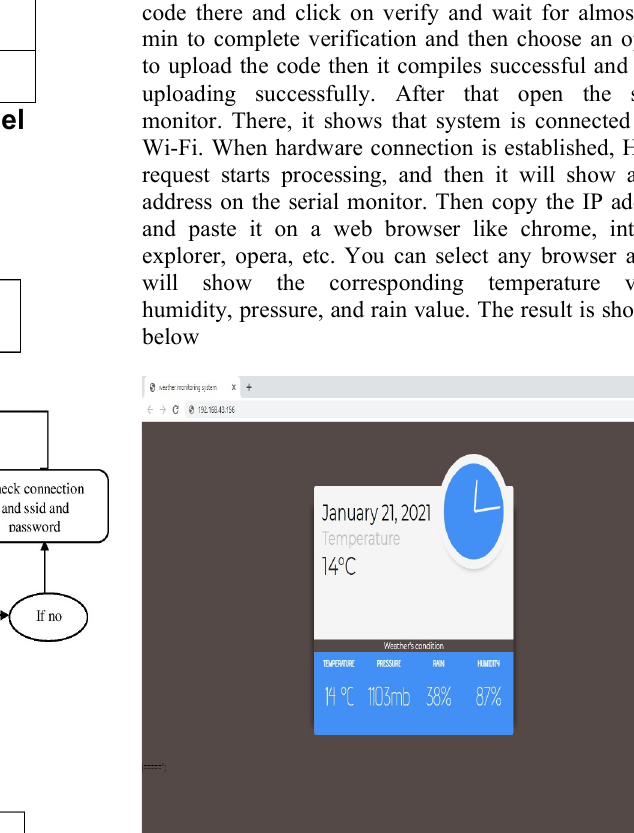
Fig.4. Final Result another web page